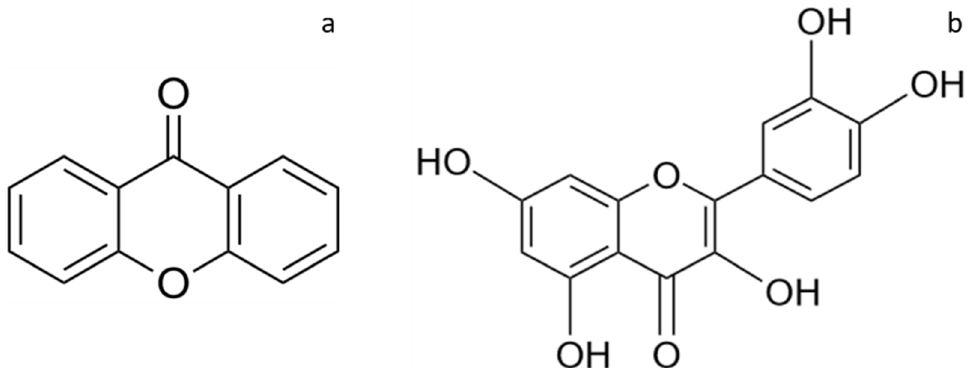
Figure 3. Chemical structures of xanthone ( a ) and quercetin ( b ).